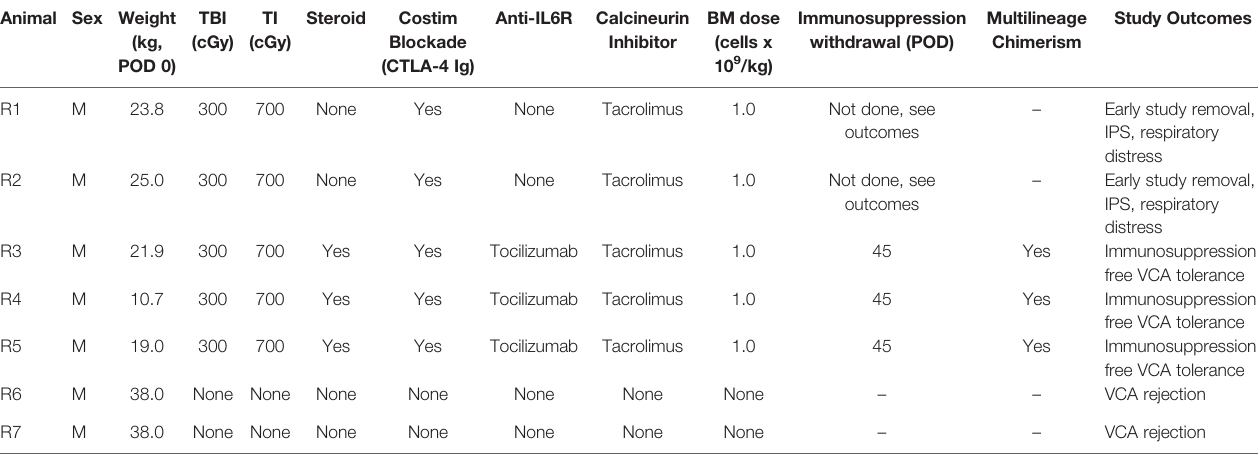
TABLE 1 | Description of transplant characteristics. Animal Sex Weight